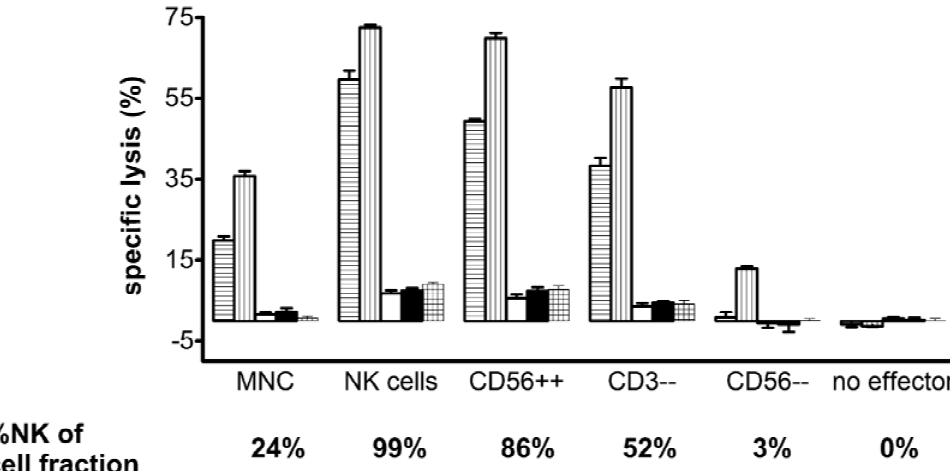
Figure 4. The bsscFv 33-16 (horizontal stripes) and the sctb 33-16-33 (vertical stripes) induced lysis of CD33-positive Molm-13 cells in an ADCC experiment with MNCs as effector cells at an E:T ratio of 10:1. The extent of lysis was raised when purified natural killer (NK) cells were used as effectors at the same E:T ratio. Enrichment of CD56-positive cells from the MNC portion also elevated the extent of lysis compared with the whole MNC population. Depletion of CD3 positive cells marginally reduced lysis, whereas after depletion of CD56-positive cells, lysis was strongly reduced, indicating that NKT-cells residing in this residual compartment, were not major contributors to the overall degree of lysis mediated by the sum of all CD16-positive effector cells. No lysis was obtained without effector cells. Open bars, control bsscFv 7-16; filled bars, control sctb 7-16-7, carrying scFv binding domains for CD7; checkered pattern, no ab-derivative added. ++, enriched for; --, depleted of; Data points are presented as mean values from triplicate determinations, error bars represent SEM; E:T ratio, effector-to-target cell ratio; MNC, mononuclear cells. From Singer 2010 [138] with